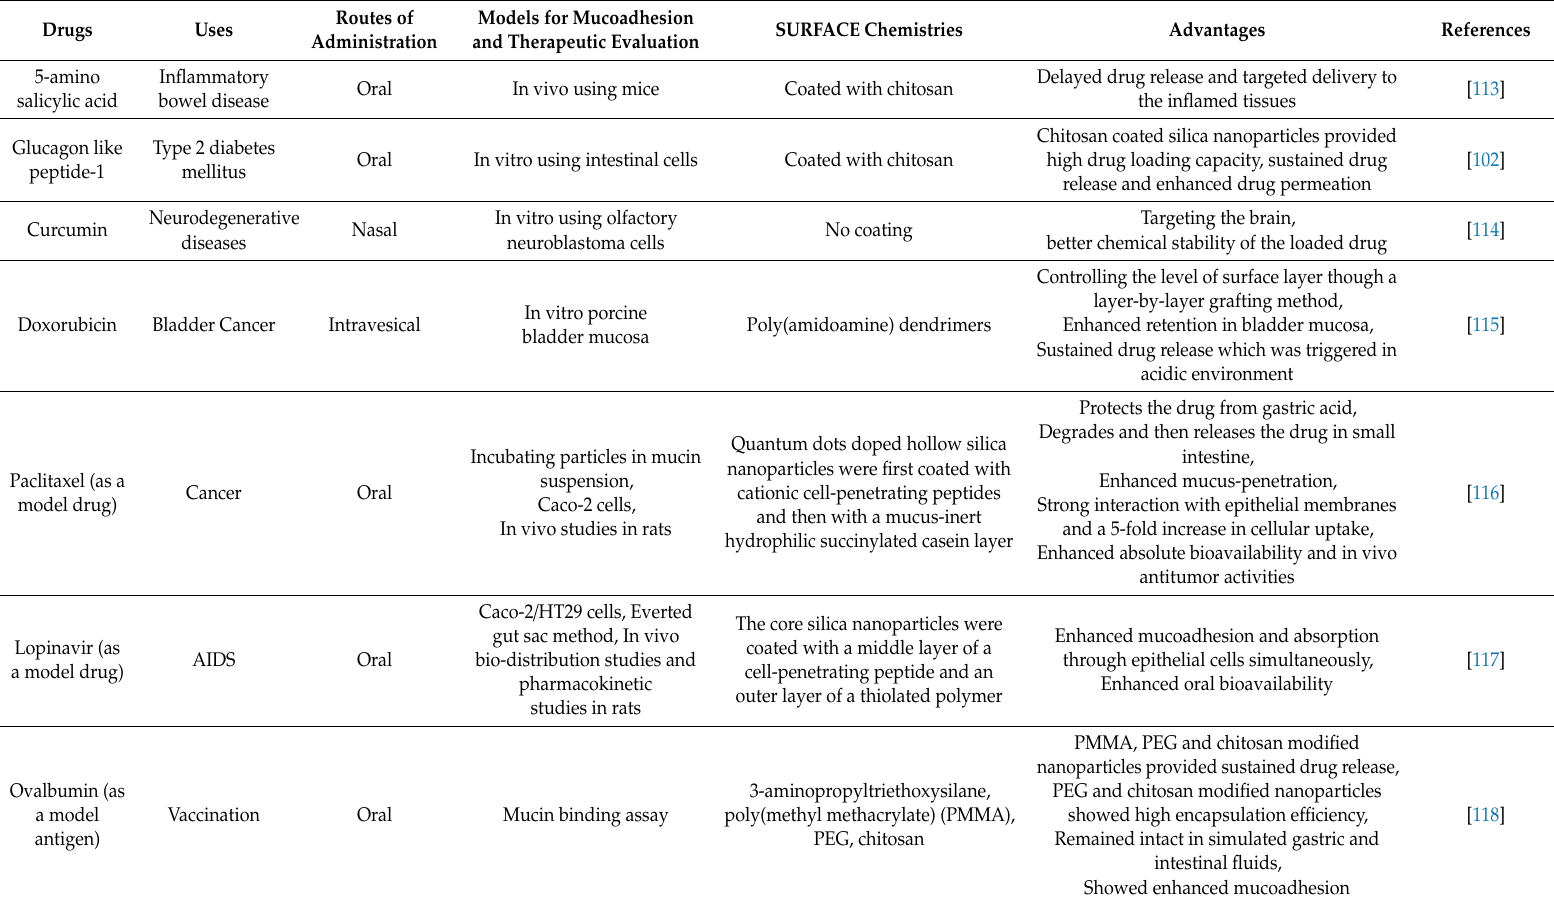
Table 1. Some examples of transmucosal drug delivery using silica nanoparticles in the